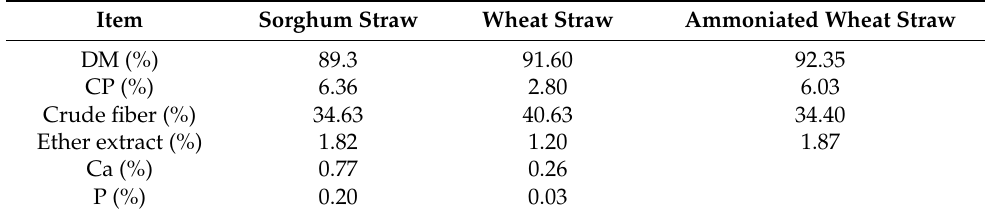
Table 1. Chemical composition of sorghum straw and wheat straw (dry matter basis, DM %).